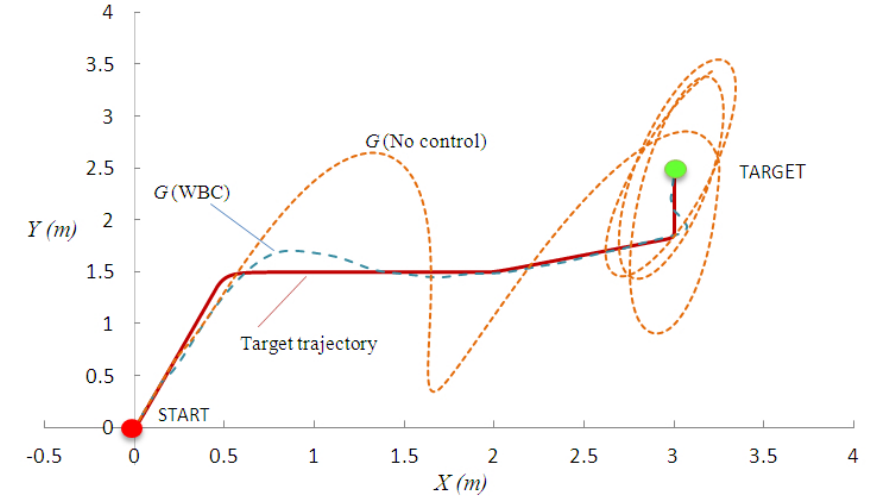
Figure 10. Trajectory tracking, plan view, showing the paths of the mass centre of the